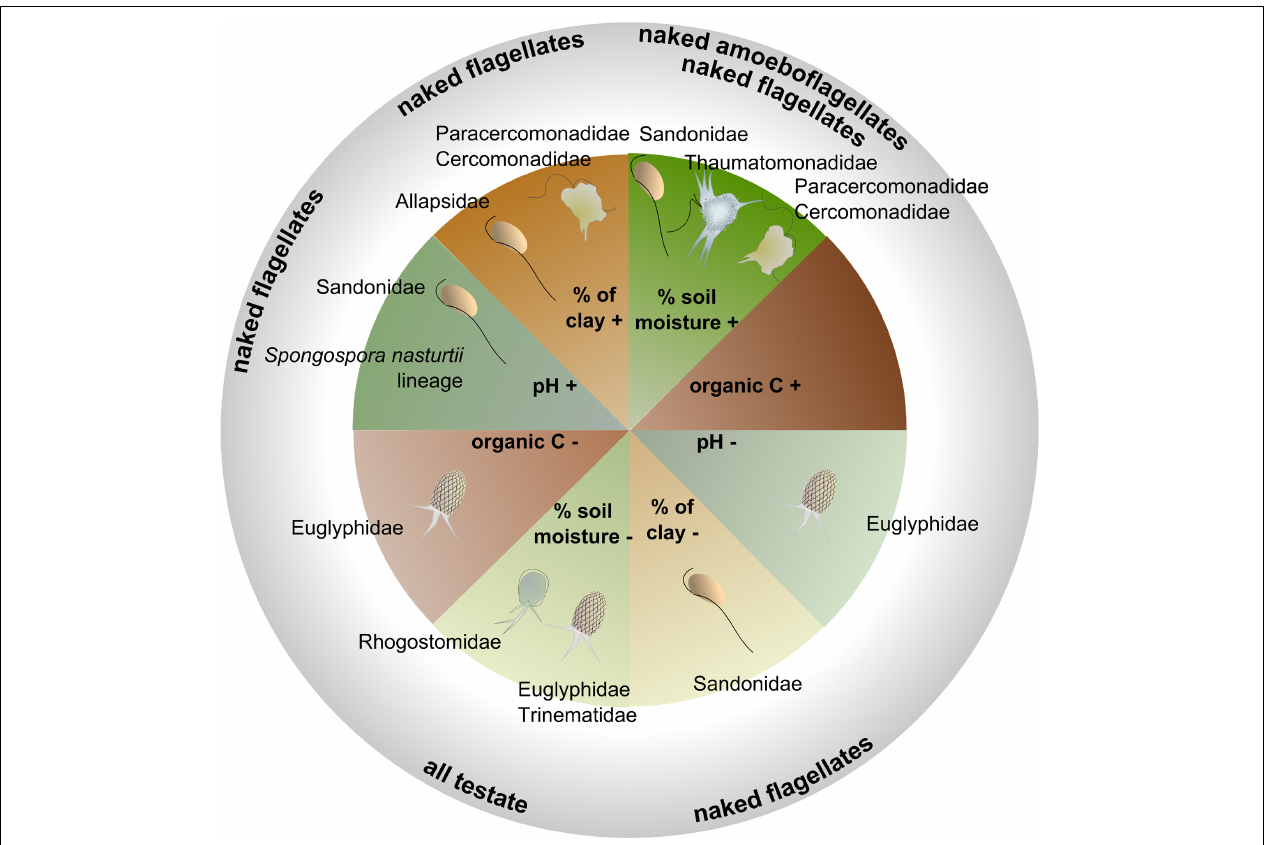
FIGURE 6 | Schematic illustration showing the positive (+) or negative (–) interactions between the four most influential soil physicochemical parameters (based on the ANOVA, Table 3 ), and the relative abundances of the major families or morphotypes (details of the models in Supplementary Table S6 ).